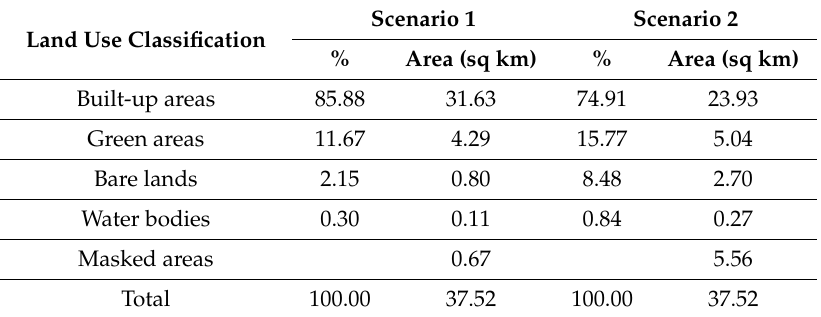
Table 7. The di ff erent land-use area in Nakhon Ratchasima in 2026 from the CA-Markov model. Scenario Land Use Classification